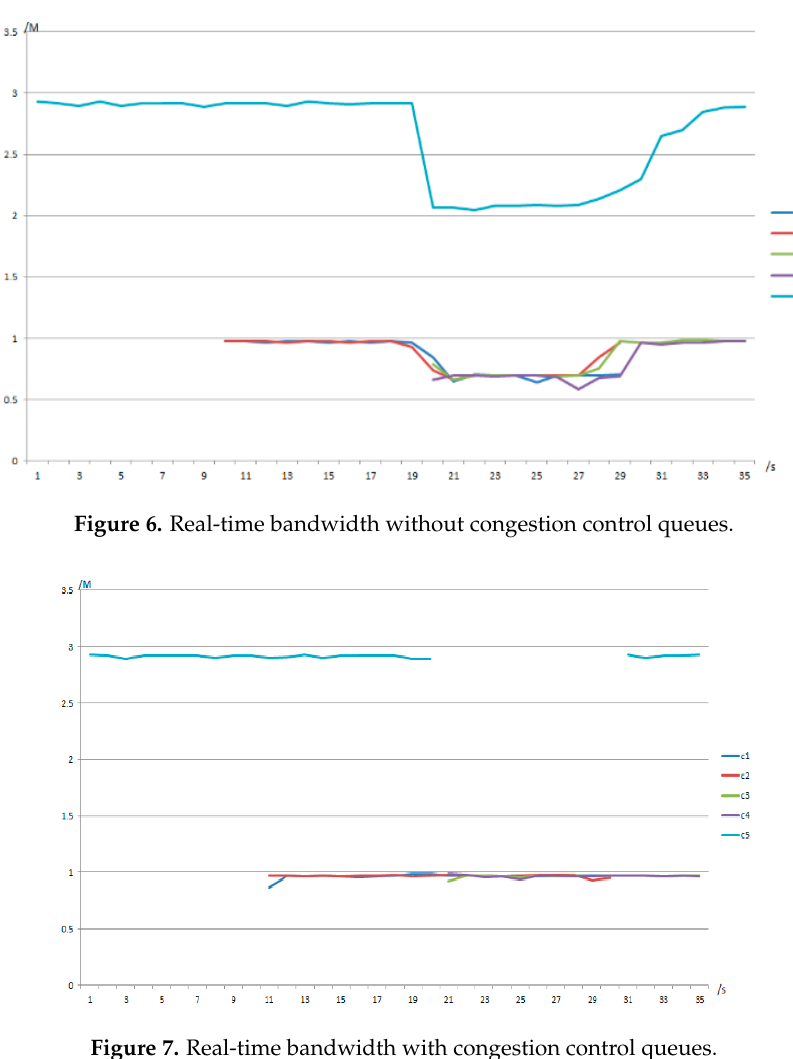
Figure 7. Real-time bandwidth with congestion control queues.